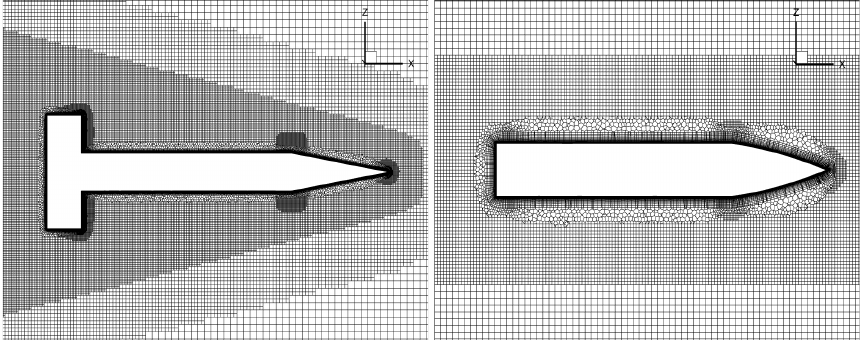
Figure 9. Mesh refinement around the model for the Basic Finner ( left ) and the ANSR ( right